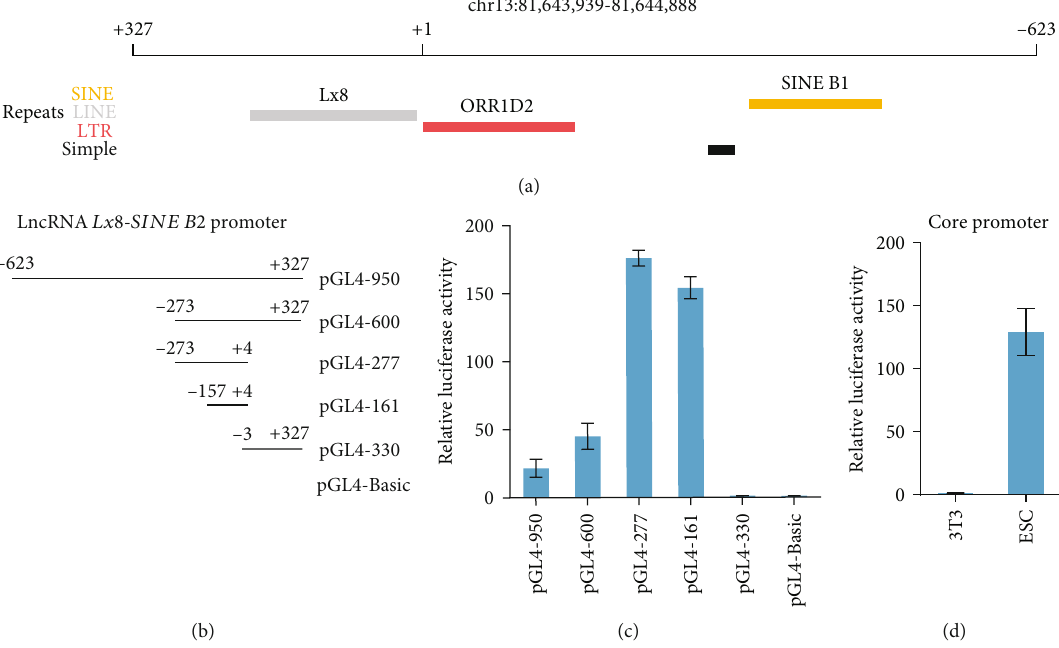
Figure 3: Dissection of lncRNA Lx8-SINE B2 promoter region. (a) Schematic of the positions of TEs on according to mouse mm10 genome the promoter region of lncRNA Lx8-SINE B2 . (b) Schematic of various length fragments of lncRNA Lx8-SINE B2 promoter constructs. (c) Activities of various length fragments of lncRNA Lx8-SINE B2 promoter constructs were determined by luciferase reporter gene assays in E14 ESCs. Biological-triplicate data ( n = 3 dishes) are presented as mean ± s : e : m . (d) Luciferase assay analysis of core promoter activity of lncRNA Lx8-SINE B2 in ESCs and 3T3 cells. Biological-triplicate data (n =3 extracts) are presented as mean ±